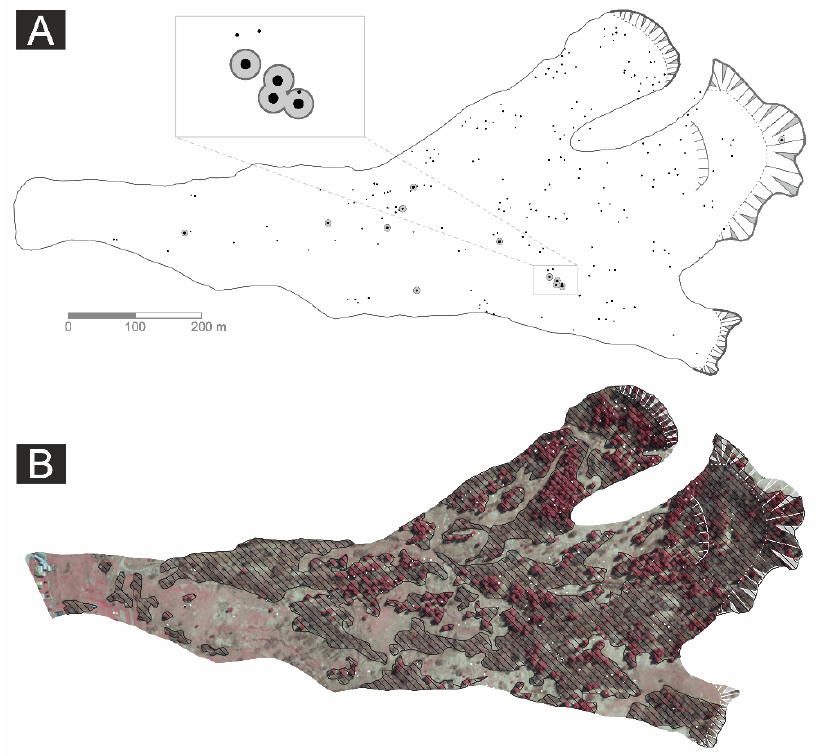
Figure 5. The area affected by landslide reactivation ( A ) in a case year 2005 based on tree buffers (the detail shows the overlap of buffers in the cluster of affected trees) and the afforestation of the Ľubietová landslide ( B ).